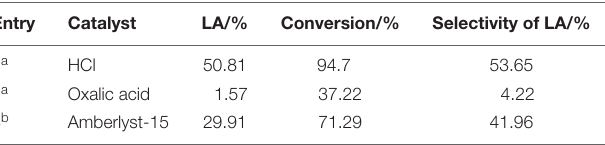
TABLE 1 | Effect of different catalysts on cellulose conversion and LA yield.